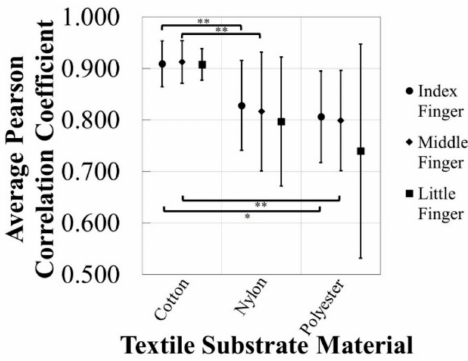
Figure 7. The average Pearson correlation coefficients for the comparison of the EDA stimulus responses of the rigid electrodes (1.50 cm distance, 1.00 cm 2 surface area) to the signals of the e-textile electrodes of 0.12 cm 2 surface area with distances of 0.40 cm integrated into cotton, nylon, and polyester textile substrates on the distal phalanx of the index, middle, and little finger on the palm of the hand. Standard deviations are shown and one-tailed t -test results with p -values < 0.05 (*) and p -value < 0.10 (**) are indicated. For each value n =